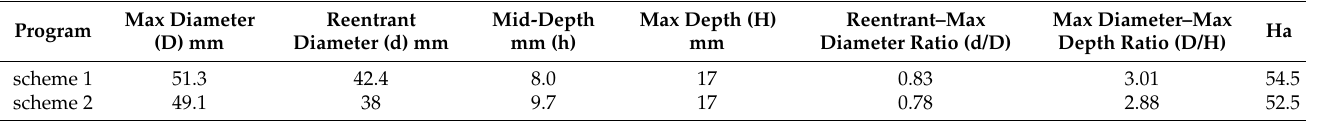
Table 2. Basic size of the